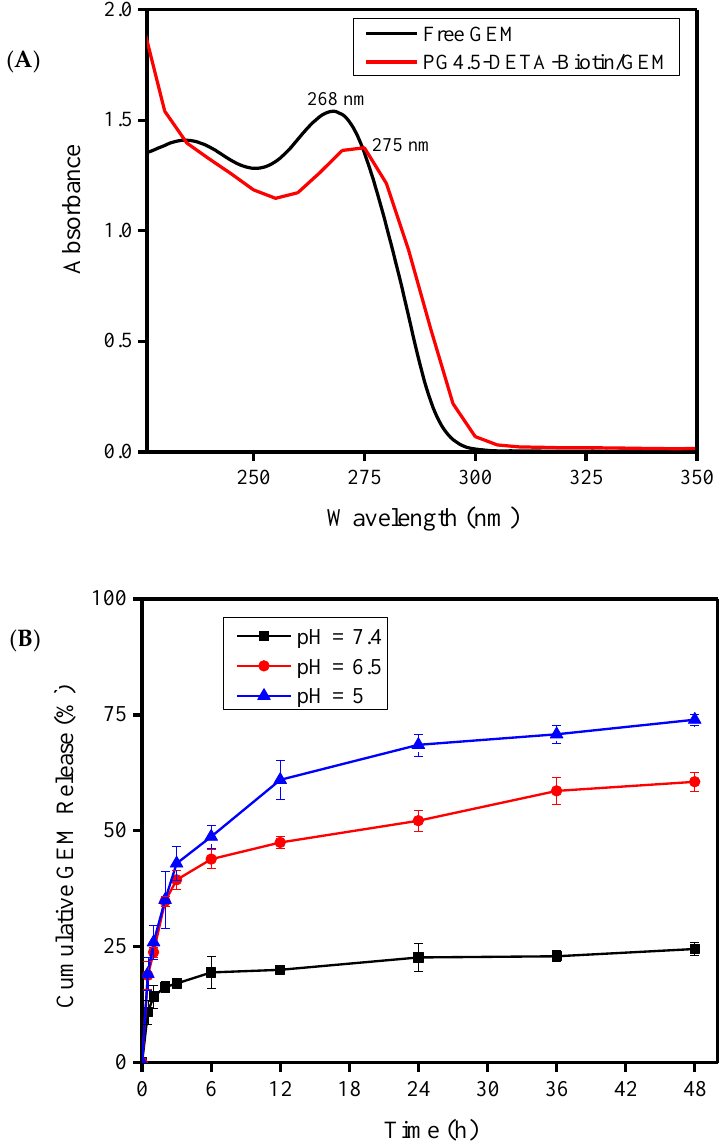
Figure 4. ( A ) UV—visible spectra of gemcitabine and PG4.5-DETA-biotin / GEM nanoparticles. Figure 4. ( A ) UV – visible spectra of gemcitabine and PG4.5-DETA-biotin/GEM nanoparticles. ( B ) In ( B ) In vitro release of gemcitabine from PG4.5-DETA-biotin / GEM nanoparticles at pH 7.4, 6.5, and 5. vitro release of gemcitabine from PG4.5-DETA-biotin/GEM nanoparticles at pH 7.4, 6.5, and 5. Results Results are mean ± SD of triplicate measurements ( n = are mean ± SD of triplicate measurements ( n = 3).